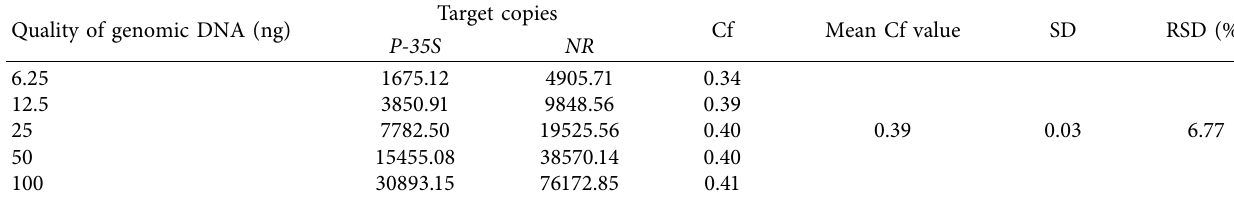
NA: not applicable. Table 4: Conversion factor (Cf) estimation of the reference molecule pGMT27 by qPCR. Quality of genomic DNA (ng)